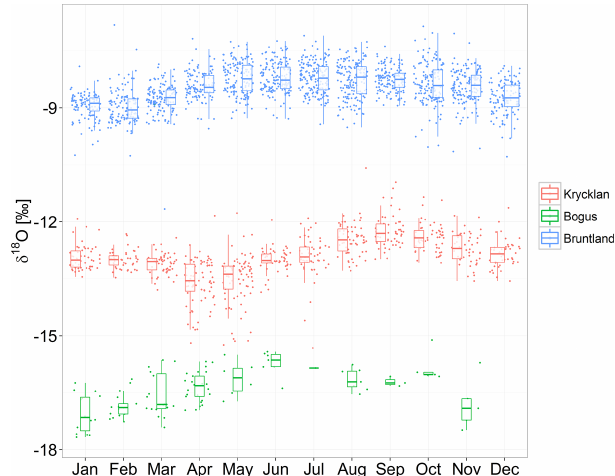
Figure 2. Box plots showing the seasonality of streamflow for each catchment by grouping daily streamflow (5 years of data for Bruntland, 8 for Bogus, and 10 for Krycklan) to monthly bins. Coloured box shows the 25th and 75th quantiles, small horizontal line the median, and vertical line the extent of 5th and 95th per- centiles. High flows for Krycklan and Bogus are brought about by snowmelt occurring typically in April–May. For Bruntland, flows are more evenly distributed through the year with highest flow during December–February with occasional snowmelt influence. Colour coding (red for Krycklan, blue for Bruntland, green for Bo- gus) is maintained throughout the paper.